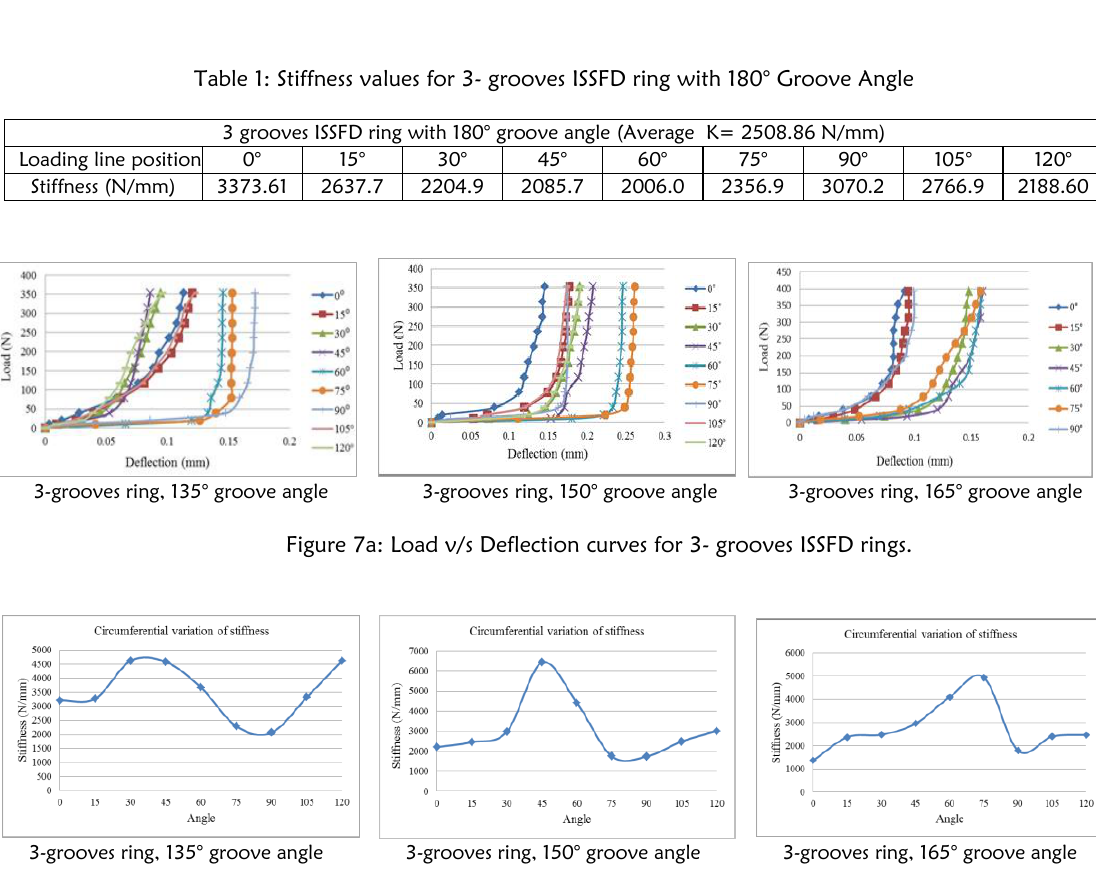
Fig 7b: Circumferential variation of Stiffness up to 120° for 3- grooves ISSFD rings.